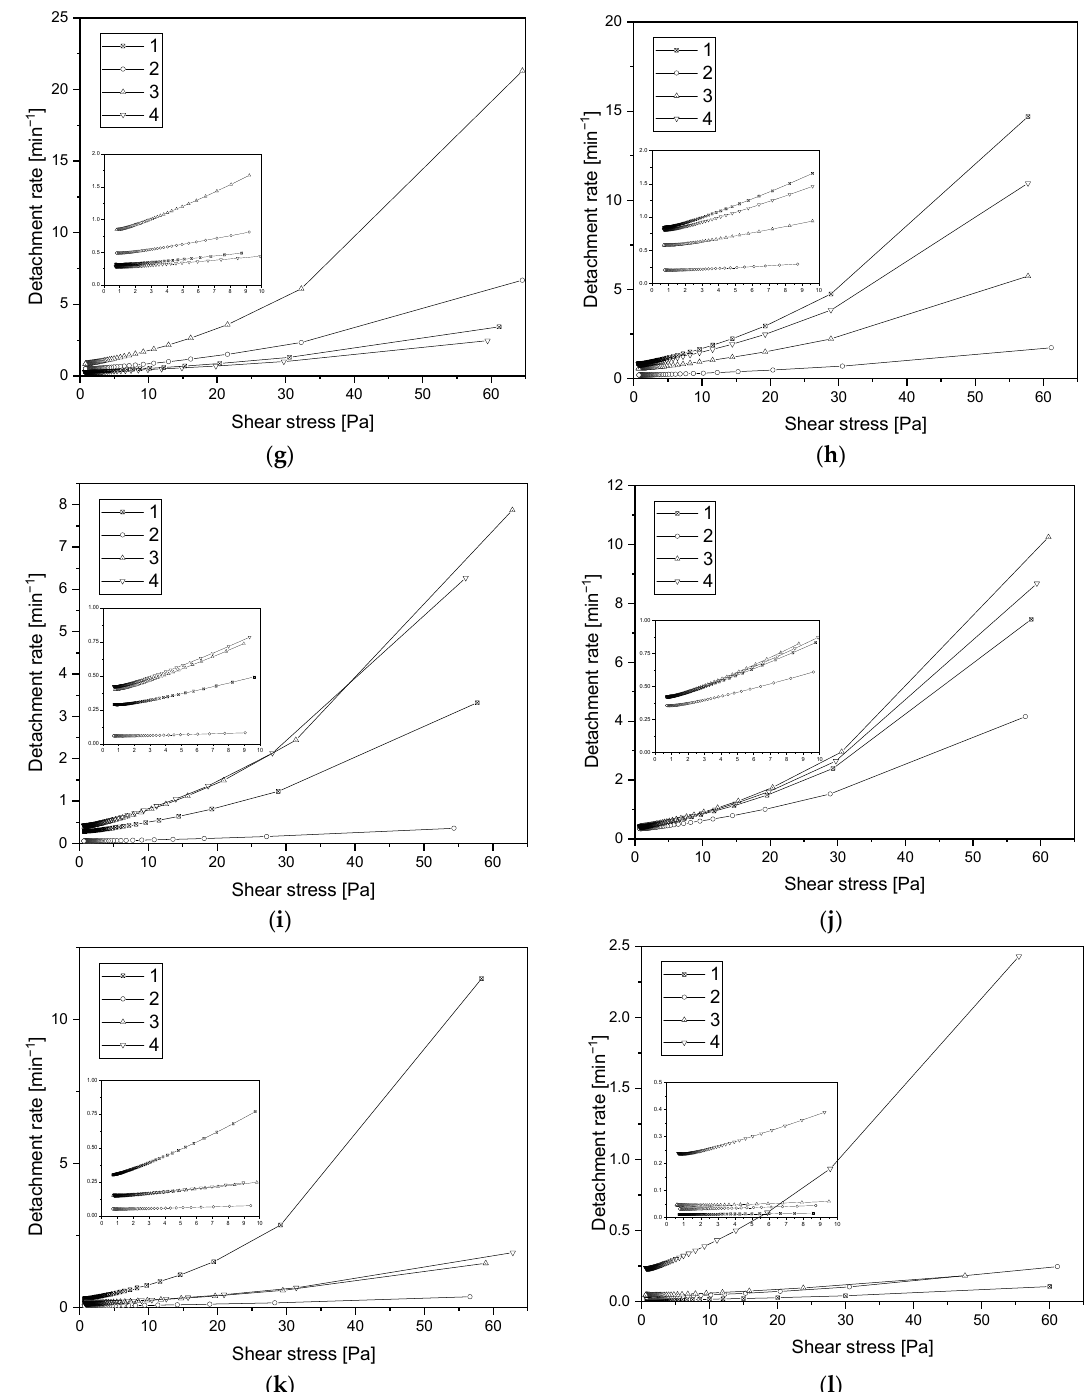
Figure 8. ( a ) Detachment efficiency of Red blood cells after 2.5 min flow; ( b ) Detachment efficiency of buffy coat after 2.5 min flow; ( c ) Detachment efficiency of Red blood cells after 5 min flow; ( d ) Detachment efficiency of buffy coat rate after 5 min flow; ( e ) Detachment efficiency of Red blood cells after 7.5 min flow; ( f ) Detachment efficiency of buffy coat after 7.5 min flow; ( g ) Detachment rate of Red blood cells after 2.5 min flow; ( h ) Detachment rate of buffy coat after 2.5 min flow; ( i ) Detachment rate of Red blood cells after 5 min flow; ( j ) Detachment rate of buffy coat rate after 5 min flow; ( k ) Detachment rate of Red blood cells after 7.5 min flow; ( l ) Detachment rate of buffy coat after 7.5 min flow.